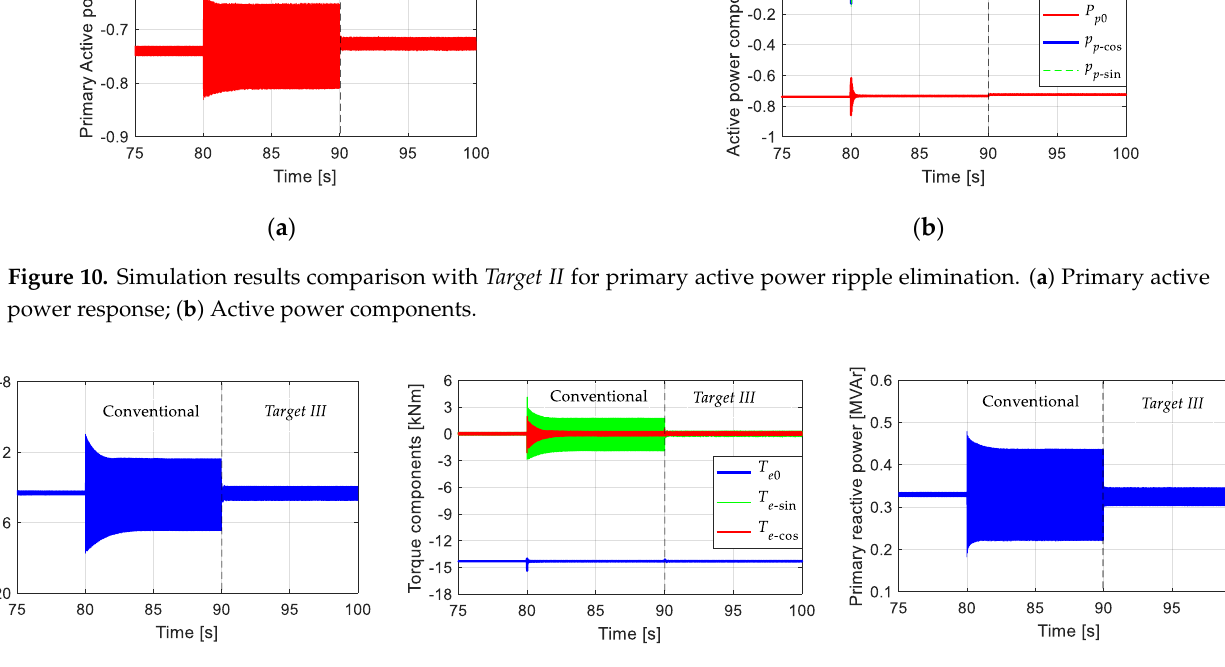
Figure 11. Simulation results comparison with Target III for torque and reactive power ripple elimination. ( a ) Torque re- Scheme 10. Hz fundamental component (positive slip 60 – 50 Hz) and the 110 Hz harmonic component (negative slip 60